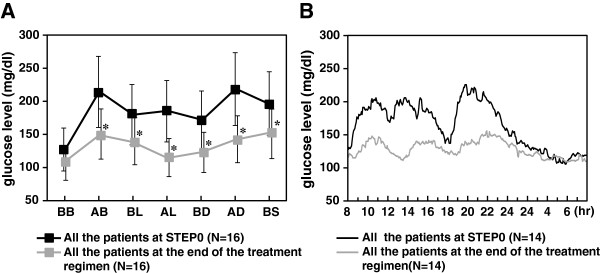
Median 7-point SMBG and CGM of all the patients at STEP0 and at the end of the treatment regimen. A. Median 7-point SMBG of all the patients at STEP 0 and at the end of the treatment regimen. Black line: all the patients at STEP 0, Gray line: all the patients at the end of the treatment regimen. BB: before breakfast, AB: after breakfast, BL: before lunch, AL: after lunch, BD: before dinner, AD: after dinner, BS: before sleep. *value of SMBG of all the patients at STEP 0 vs. those at the end of the treatment regimen P < 0.05. B. Median CGM of all the patients at STEP 0 and at the end of the treatment regimen. Black line: all the patients at STEP 0, Gray line: all the patients at the end of the treatment regimen.